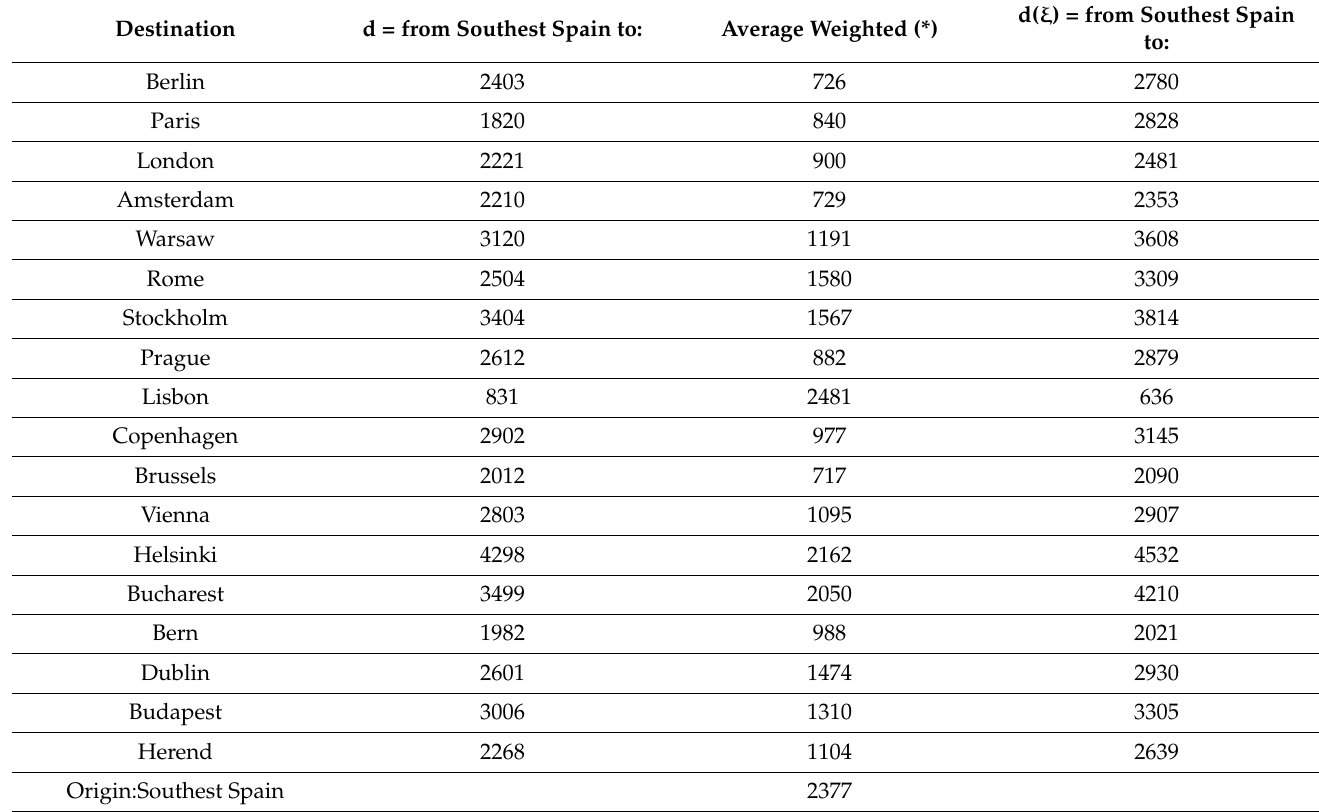
Table A1. Distance summary in